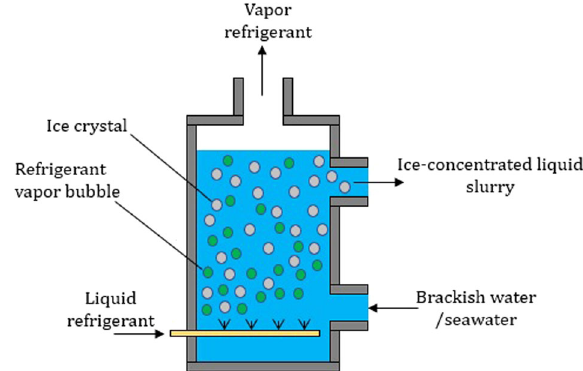
Fig. 2 Schematic of the direct contact freeze-concentration process. The cold liquid refrigerant is mixed directly with the